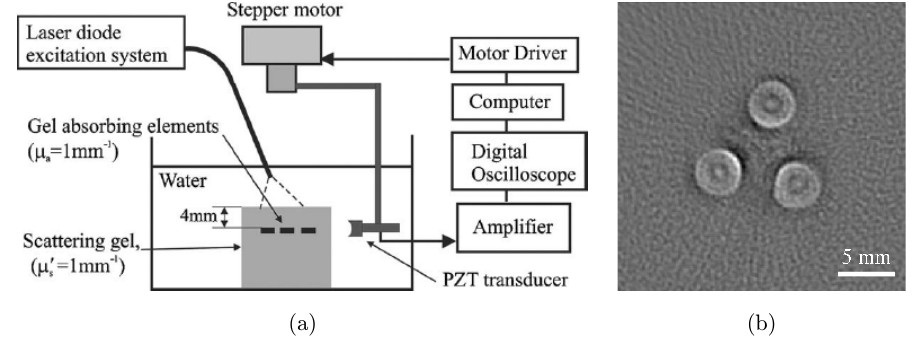
Fig. 1. (a) Cylindrical scanning LD-PAT system and (b) image obtained with a pulse duration of 500 ns (images adapted from Refs. 78,